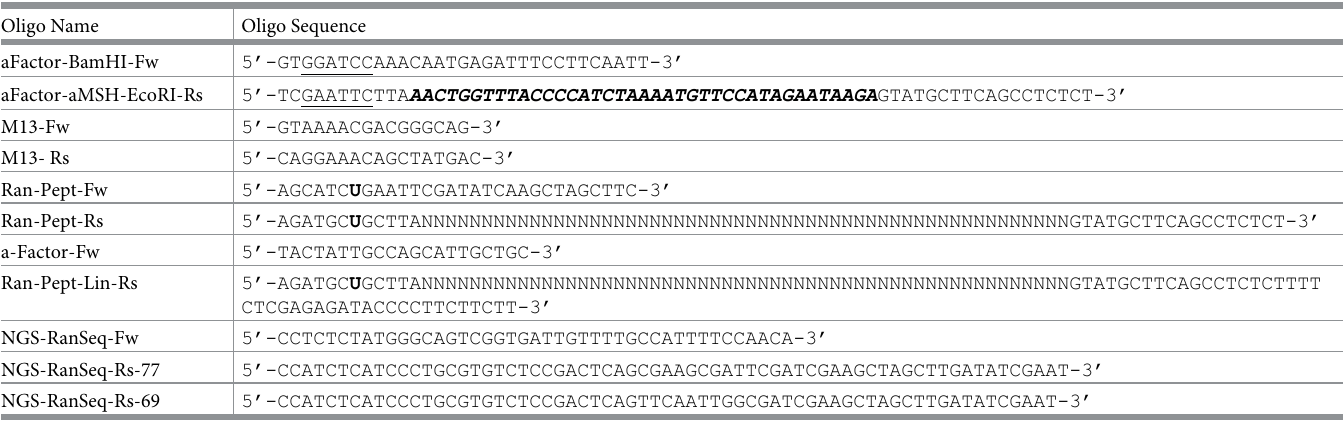
Table 1. Employed oligonucleotides. Restriction sites are underlined, coding sequences are in Bold-Italic , and deoxy uridine is in Bold . Oligo